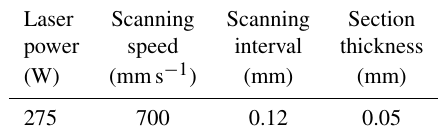
Table 3. Selective laser melting process parameters of 316L stain- less